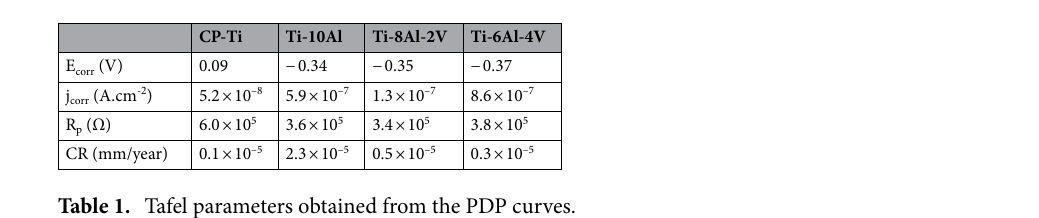
Table 1. Tafel parameters obtained from the PDP curves.